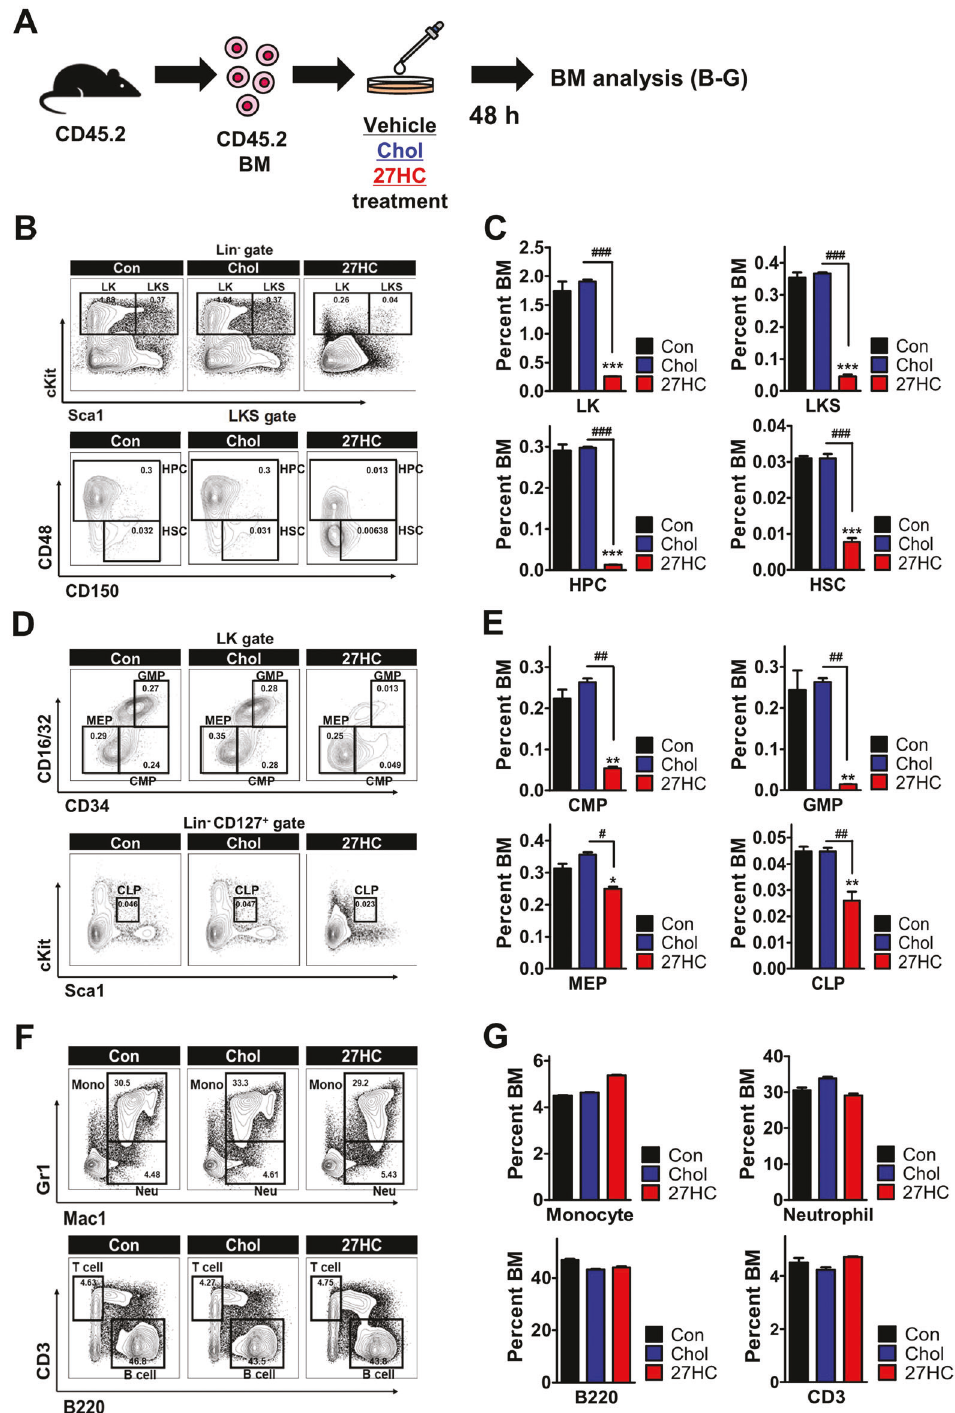
Fig. 1 The exogenous addition of 27HC depletes hematopoietic stem and progenitor cells (HSPCs). BM cells are treated with 13 µM Cholesterol or 6.2 µM 27OHChol for 48 h, respectively. A Study overview. B FACS plot showing the frequency of LK, LKS, HPC, and HSC populations after 27HC treatment. C The frequencies of Lin − Sca1 − cKit + cells (LK), Lin − Sca1 + cKit + cells (LKS), HPCs (Lin − Sca1 + cKit + CD48 + ), and HSCs (Lin − Sca1 + cKit + CD150 + CD48 - , SLAM cells) were decreased in the BM cells after exogenous 27HC treatment. D FACS plot showing the frequency of CMP, GMP, MEP, and CLP populations after 27HC treatment. E The frequencies of common myeloid progenitor (CMP) cells (Lin − Sca1 − cKit + CD34 + CD16/32 - ), granulocyte-macrophage progenitor (GMP) cells (Lin − Sca1 − cKit + CD34 + CD16/32 + ), megakaryocyte- erythroid progenitor (MEP) cells (Lin − Sca1 − cKit + CD34 − CD16/32 − ), and common lymphoid progenitor (CLP) cells (Lin − Sca1 low cKit low CD127 + ) were decreased in the BM cells after exogenous 27HC treatment. F FACS plot showing the frequency of monocytes, neutrophils, B cells, and T cells after 27HC treatment. G The frequencies of monocytes (CD11b + cells), neutrophils (CD11b + Gr1 + cells), B cells (B220 + cells) and T cells (CD3 + cells) were observed after 27HC treatment. Data are presented as mean ± SEM. (* p ≤ 0.05, ** p ≤ 0.01, and *** p ≤ 0.001 vs. control; # p ≤ 0.05, ## p ≤ 0.01, and ### p ≤ 0.001 vs. Chol). ( n = 2 independent experiments and 3 total measurements per treatment).